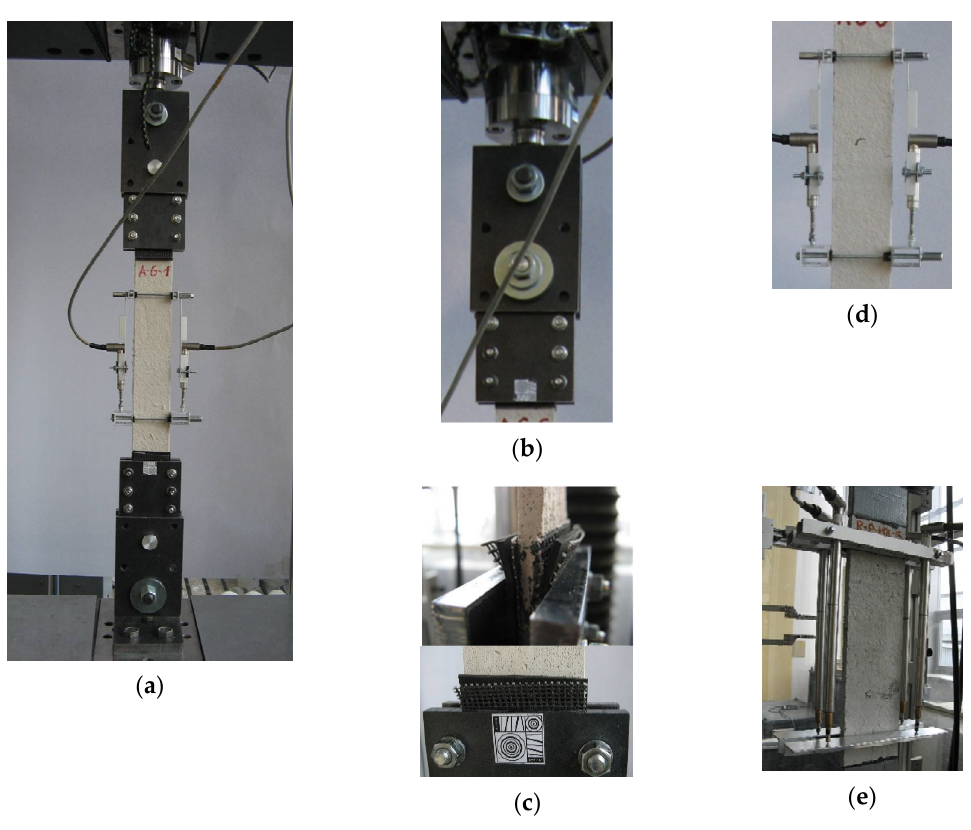
Figure 3. Test set-up: ( a ) general view; ( b ) upper clamp with clevis and force transducer; ( c ) additional layers between the steel plates of the clamping system—2× abrasive mesh, rubber sheet; ( d ) elongation measurement with 2 LVDTs, ( e ) elongation measurement with 4 LVDTs.